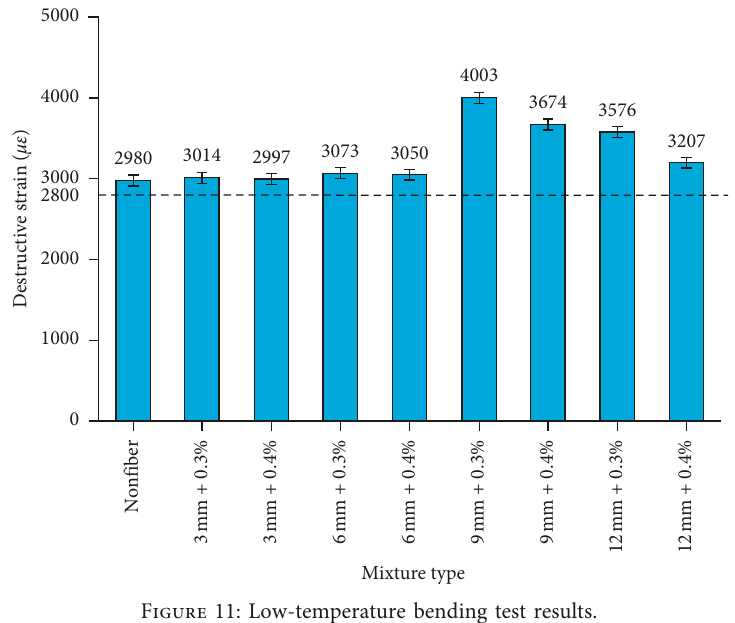
Figure 11: Low-temperature bending test results.